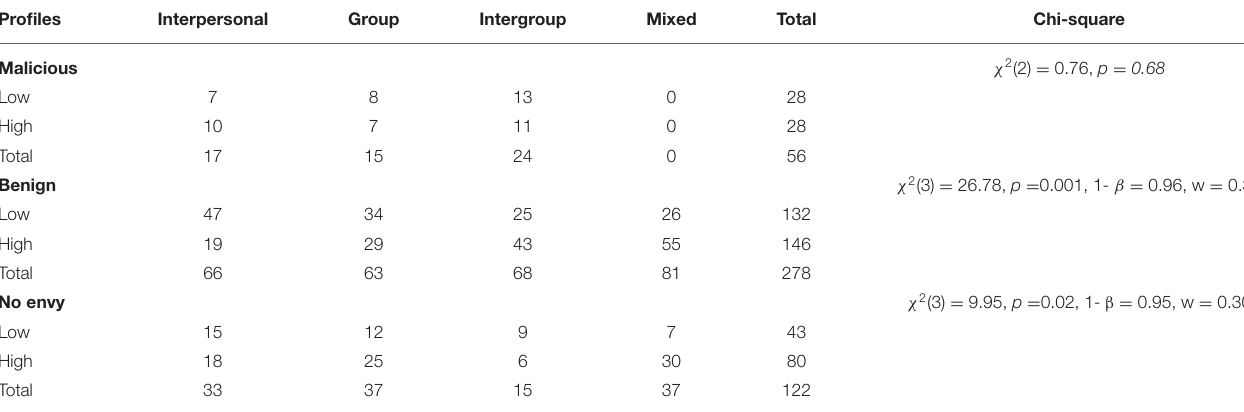
TABLE 3 | Frequency distribution of the verbal profiles in each experimental condition. Profiles